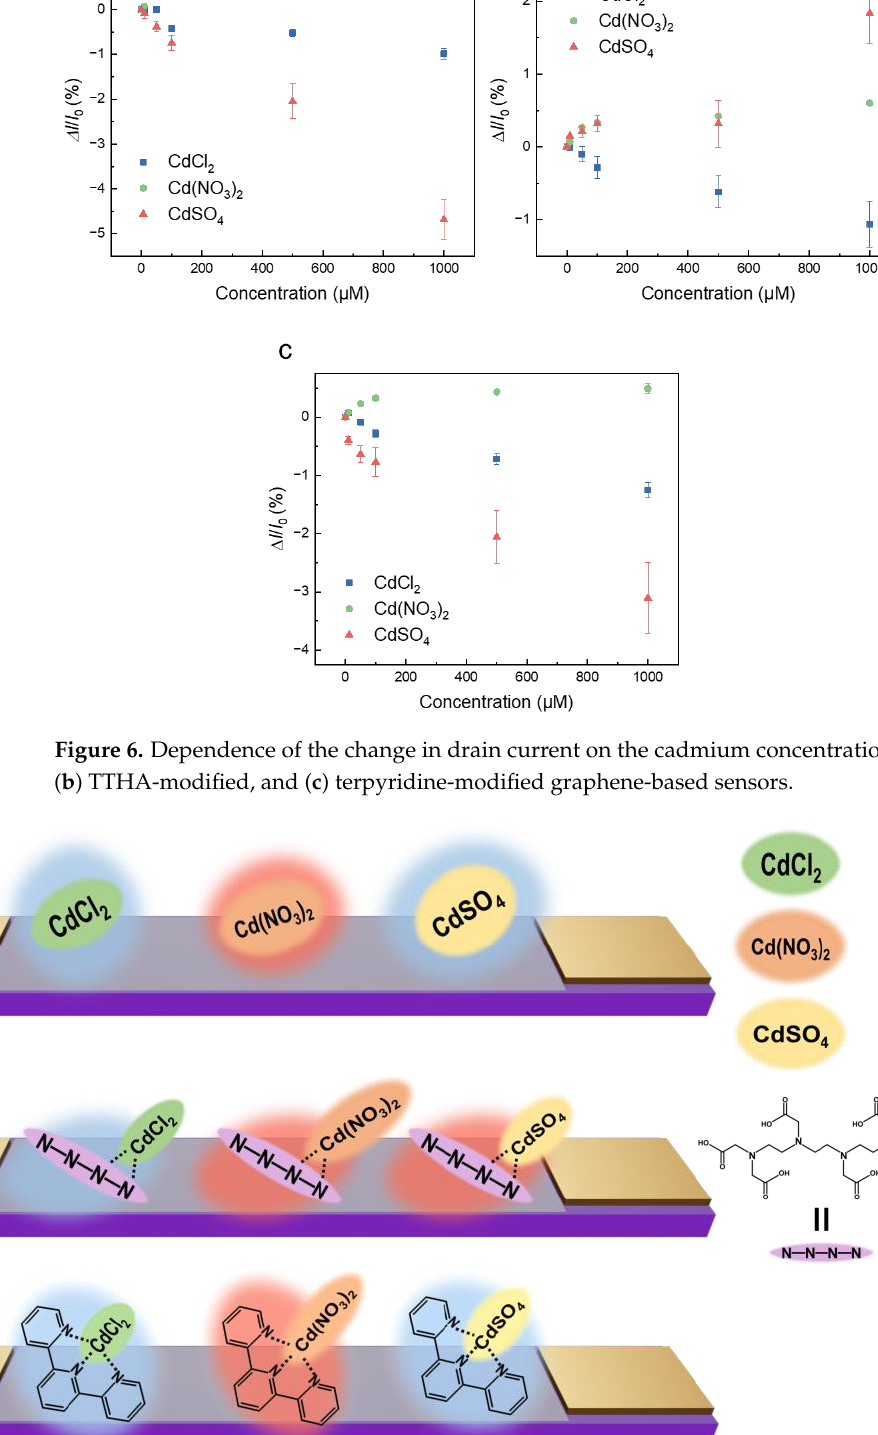
Figure 7. Schematic images of adsorption of cadmium compounds. Table 1. Drain-current response of the sensors to each cadmium compound.